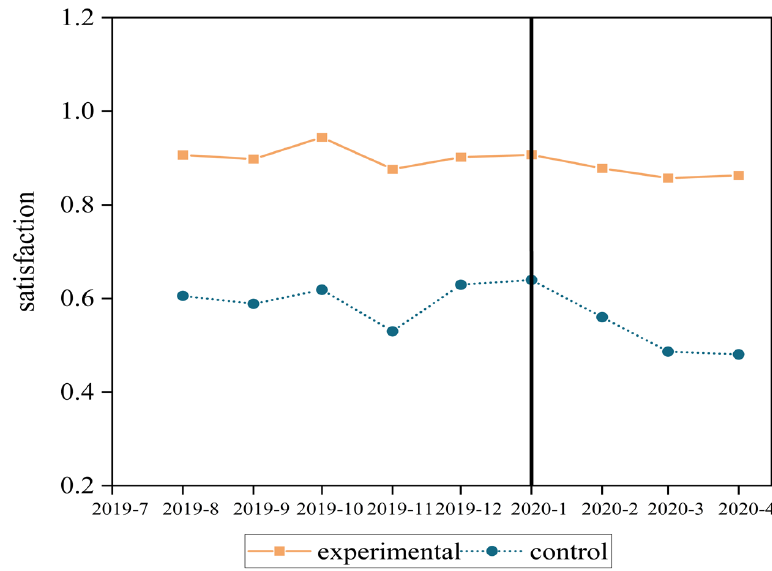
Figure 6. The time change trend of satisfaction between two